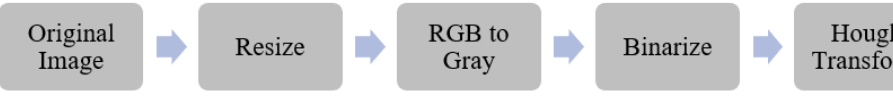
1.30 × 0.89 mm. Figure 4. ( a ) PVM probe, ( b ) captured bubble images and ( c ) bubble segmentation, image size